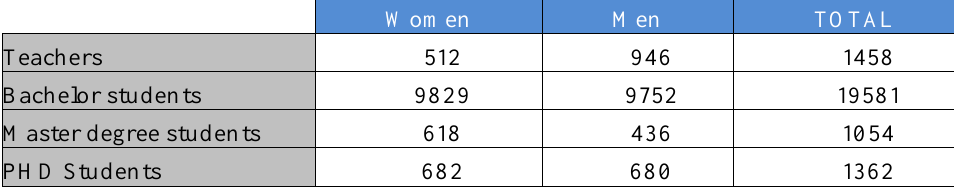
UDC Teachers and